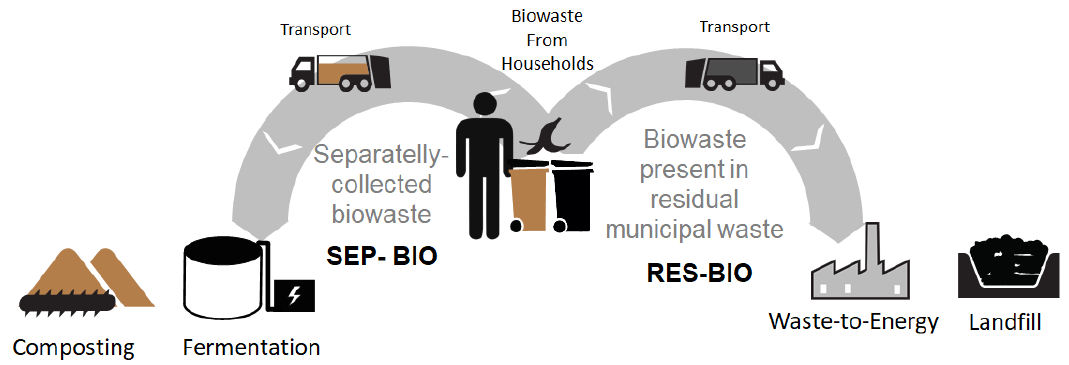
Figure 1. Two sources of biowaste and technologies considered in the analysis.